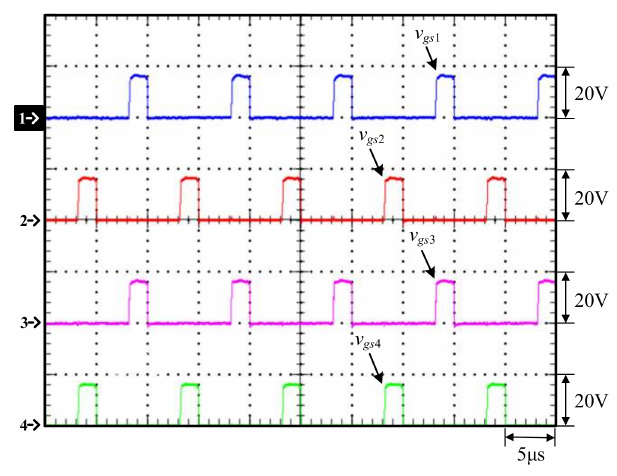
Figure 22. Measured waveforms relevant to 25% of the rated load: (1) v gs 1 ; (2) v gs 2 ; (3) v gs 3 ; (4) v gs 4 .